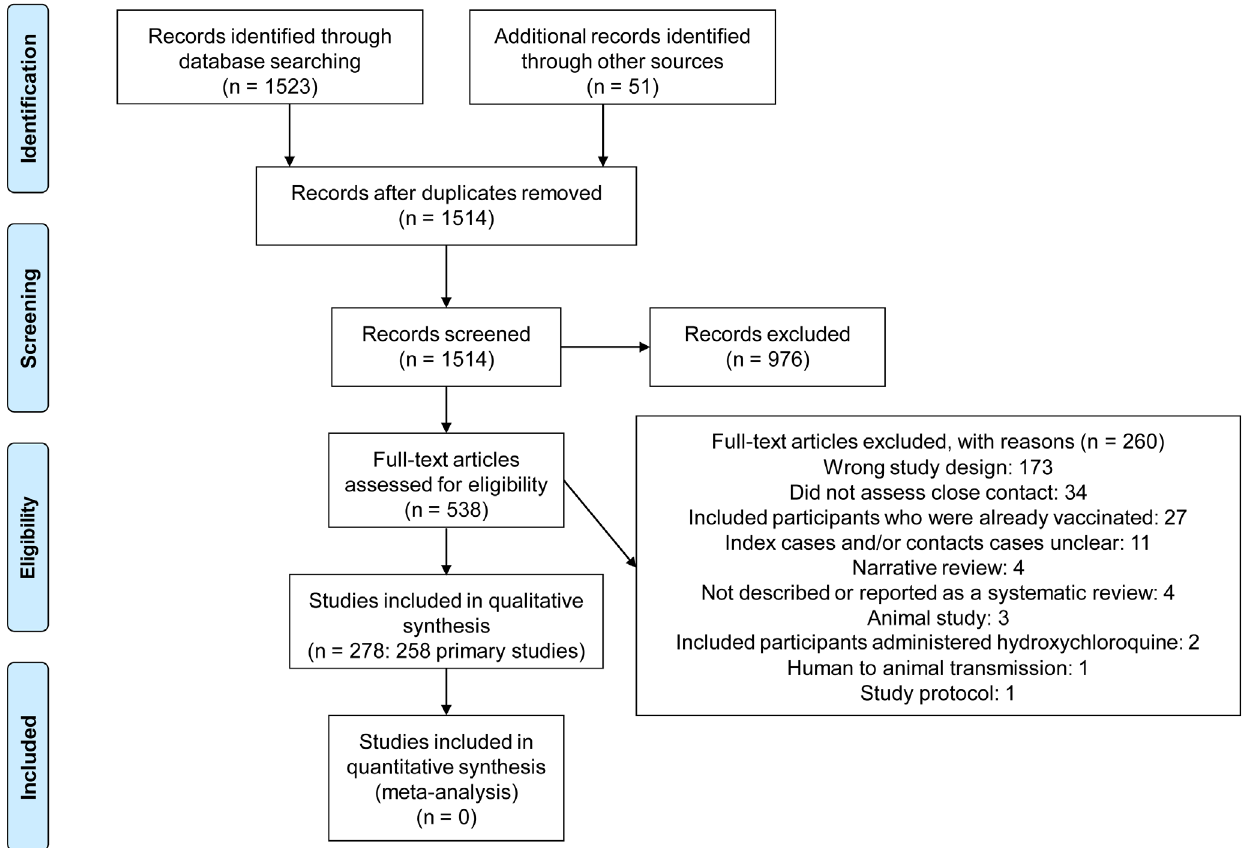
Figure 1. Flow diagram showing the process for inclusion of studies assessing close contact transmission in